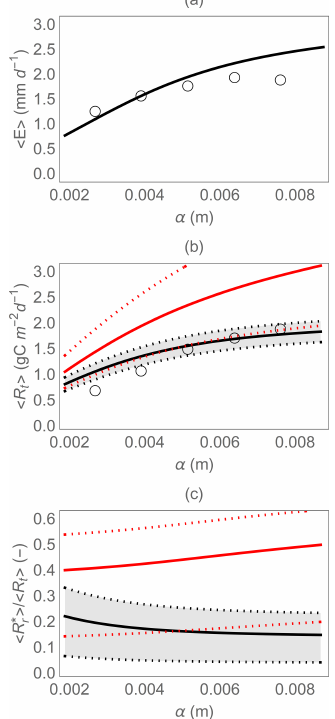
Figure 4. Comparison of model results (curves) and observations (open circles) along an experimental rainfall gradient where the mean precipitation depth ( α ) was manipulated: (a) mean evapotran- spiration rate (cid:104) E (cid:105) , (b) mean total heterotrophic respiration rate (cid:104) R t (cid:105) , and (c) fraction of the total heterotrophic respiration rate due to rewetting pulses (cid:104) R ∗ r (cid:105) / (cid:104) R t (cid:105) . In panels (b) and (c) , the dotted curves and shaded area indicate the variation caused by changes in R r , max between 5 and 35gm − 2 around the central value (solid curves) of 25gm − 2 ; the red curves indicate results using the simplified rewet- ting respiration model (Eq. 21). Parameter values are described in Sect.